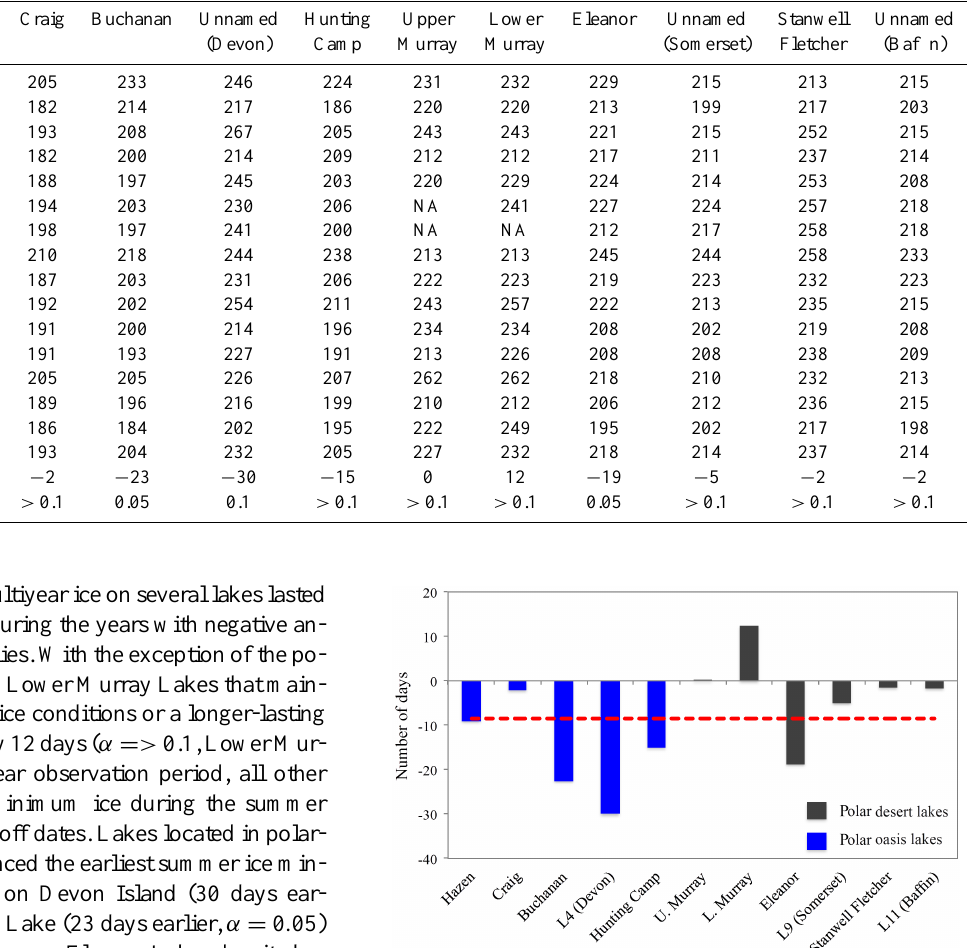
Table 4. Dates (shown as day of the year – DOY) when minimum ice cover was observed for the studied lakes from 1997 to 2011. Missing values (NA) indicate the lack of available imagery. Total days for each individual lake refer to the total number of days change during the 1997–2011 period and are reported to the mean summer ice minimum DOY of the same period. The statistical significance is indicated by the α values.